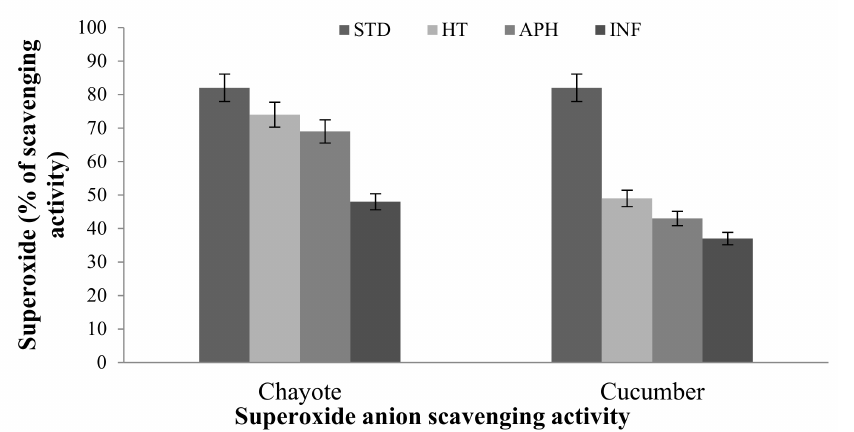
Figure 1. The superoxide anion antioxidant activity of melon fly infection in healthy (HT), apparently healthy (APH), and infected (INF) tissue extracts of cucurbit fruit. The vertical bars indicate the standard error. Significance at p ≤ 0.05.